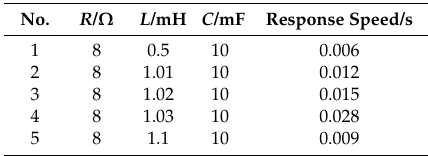
Table 2. The response speed with different load